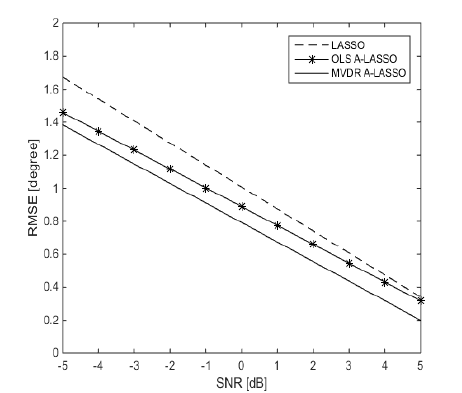
Figure 6. Performance of the three LASSO algorithms versus SNR, for two source signals at DOAs 60 ◦ and 120 ◦ , 10 snapshots and after one iteration of the MVDR A-LASSO and OLS A-LASSO